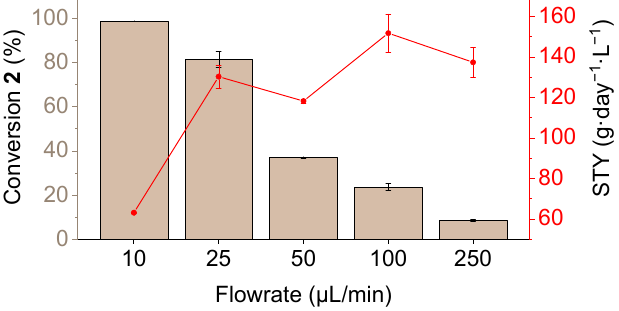
Figure 3. Flowrate dependent conversion of substrate 2 in the hydrogel loaded microreactor. The red curve indicates the calculated space-time yield (STY) for each flowrate. Substrate and cofactor were added continuously at 5 and 1 mM, respectively.